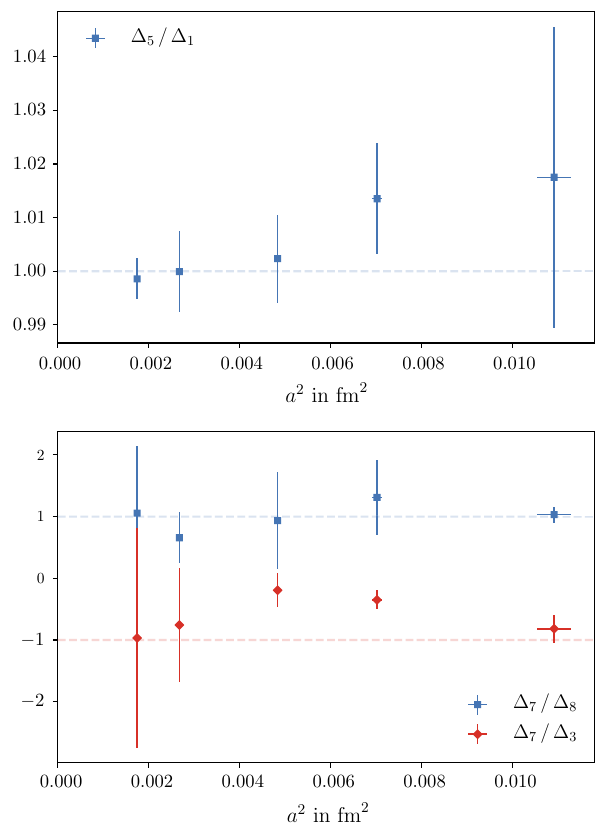
Fig. 8 Non-perturbative confirmation of the identities (24), (27) and (31). In the top panel only quark-connected diagrams contribute to the results, while in the bottom panel quark-disconnected diagrams also give